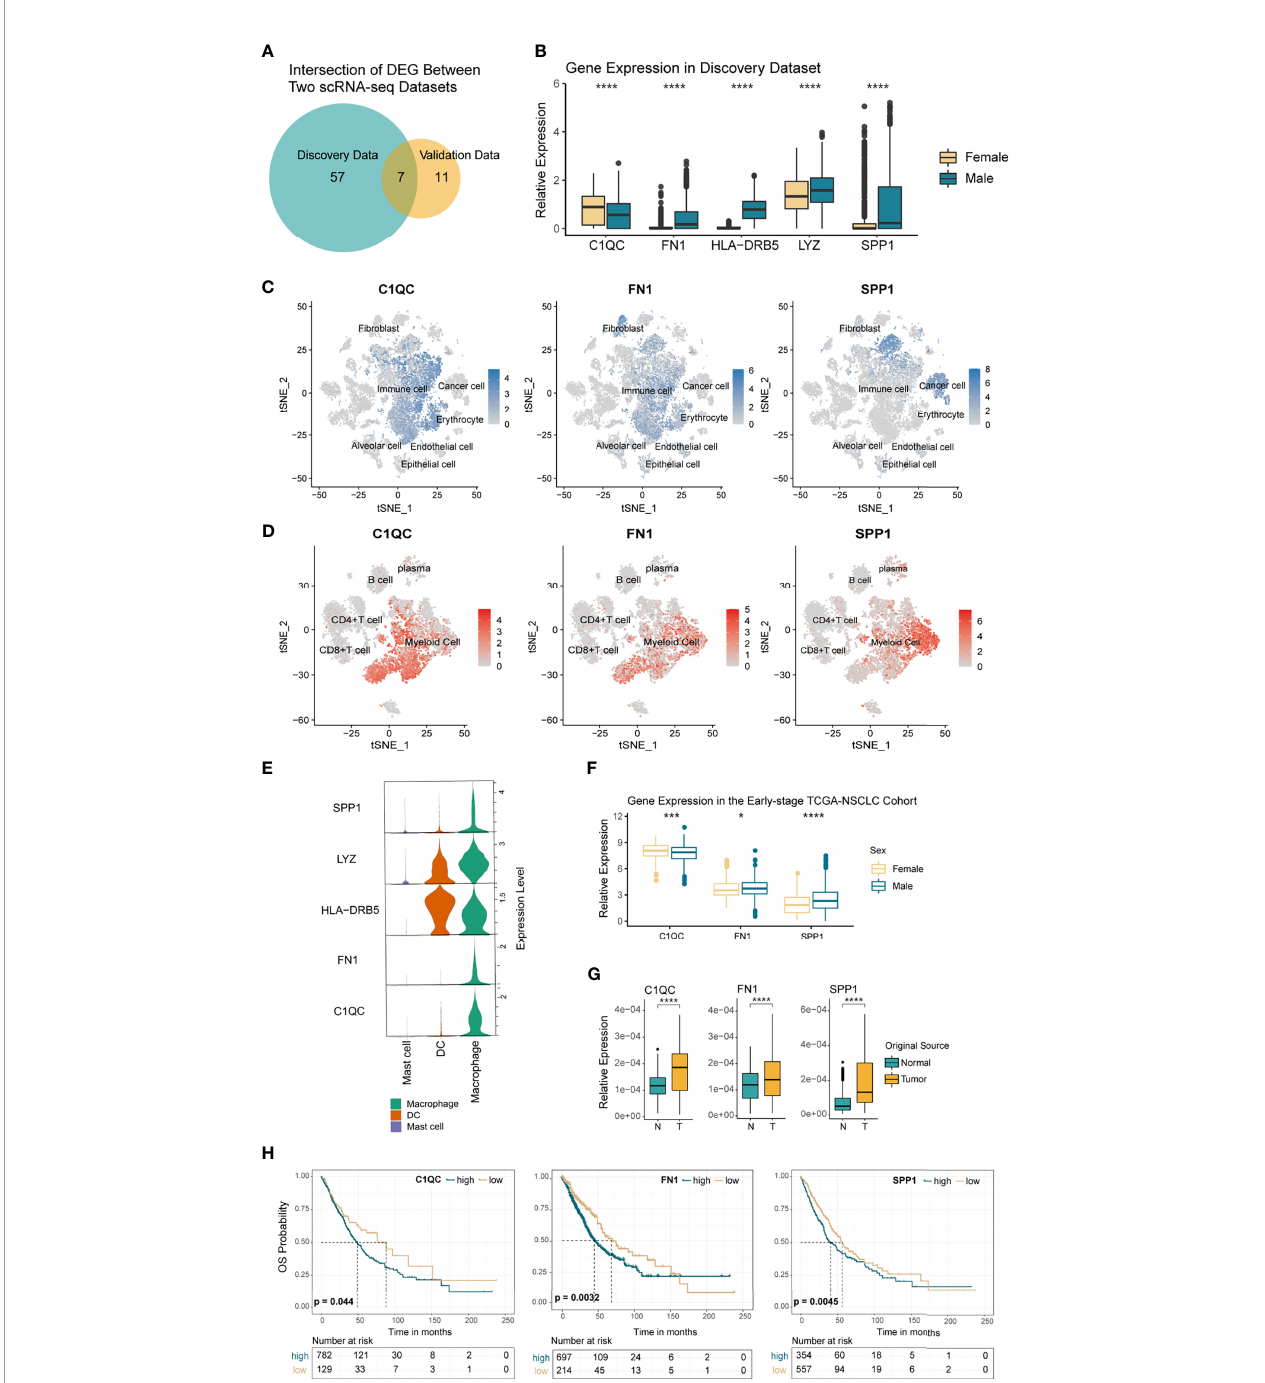
FIGURE 4 | Differentially Expressed Genes (DEGs) in TAMs by Sex. (A) Venn diagram showing the overlapped genes between the discovery and validation scRNA- seq data. (B) Boxplot showing the 5 DEGs with the same trends in each sex. p <0.05 was considered to be statistically signi fi cant, ****p < 0.001. Unpaired two- sided Wilcoxon test. (C, D) t-SNE plot showing the normalized expression of C1QC, FN1, and SPP1 in the tumor microenvironment (TME) and tumor immune microenvironment (TIME) of NSCLC. (E) Violin plot showing the relative expression of the 5 DEGs with the same trends between sexes, colored by immune cell type. (F) Boxplot comparing the TPMs of C1QC, CD45 normalized expression of FN1, and SPP1 in the early stage TCGA-NSCLC cohort (370 women vs. 541 men). Asterisk indicated different levels of p-values, *p < 0.05, ***p < 0.005, ****p < 0.001. (G) Boxplot comparing the expression variance of C1QC, FN1, and SPP1 in macrophages from normal and tumor samples. ****p < 0.001. (H) Kaplan – Meier curves based on the expression levels of C1QC, FN1, and SPP1 for TCGA NSCLC patients. P -value was calculated with a log-rank